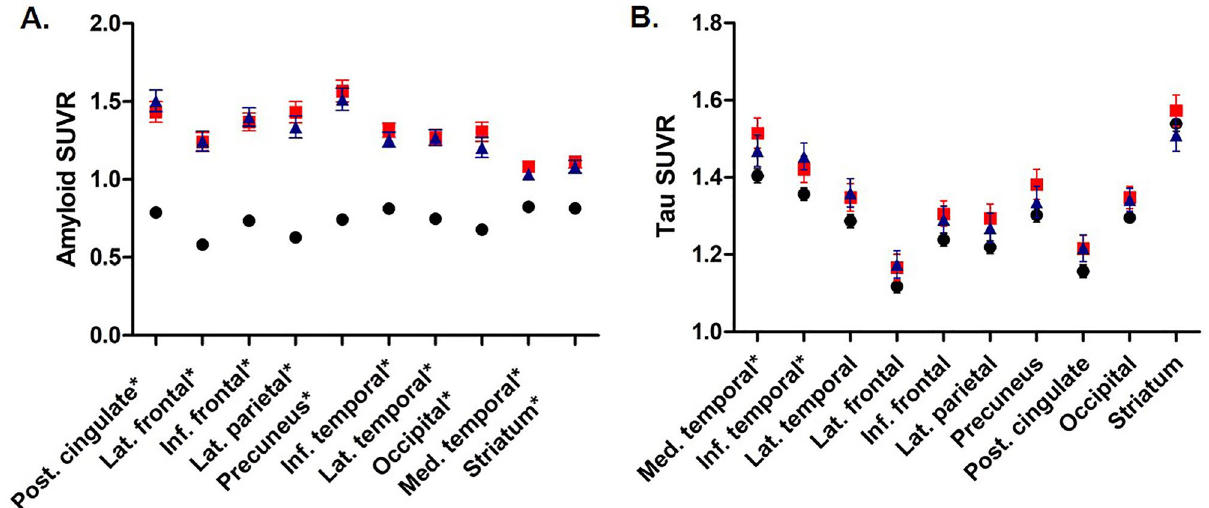
Figure 1. Regional amyloid and tau burdens (left: amyloid SUVR, right: tau SUVR). Mean ± standard deviations. *Significant difference between the groups. Circle (black): group 0 (Aß−); square (red): group 1 (Aß+ APOE4+); triangle (blue): group 2 (Aß+ APOE4−). ( A ) Regional amyloid SUVR adjusted for age; ( B ) regional tau SUVR adjusted for